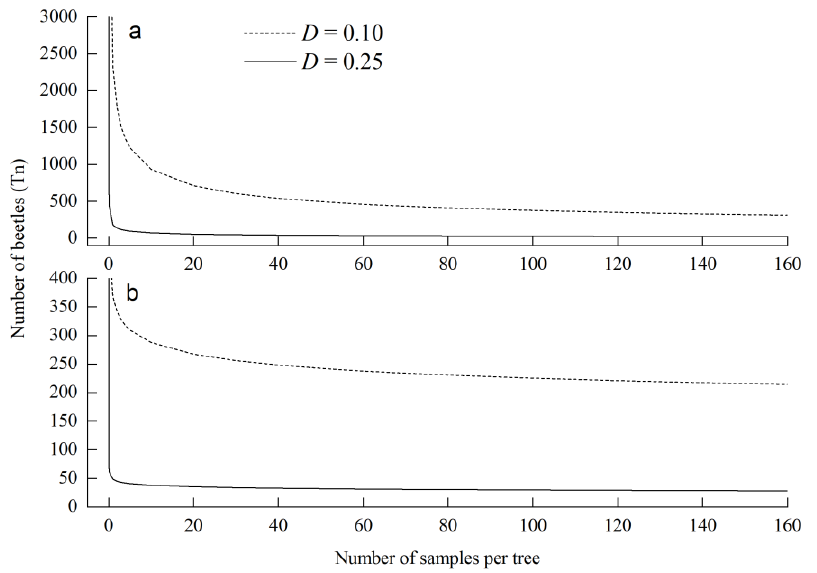
Figure 3. Green’s stop lines for fixed -precision sequential sampling of Tomicus minor ( a ) and Tomicus yunnanensis ( b ) in three Pinus yunnanensis tree sizes at precision levels of 0.1 and 0.25.